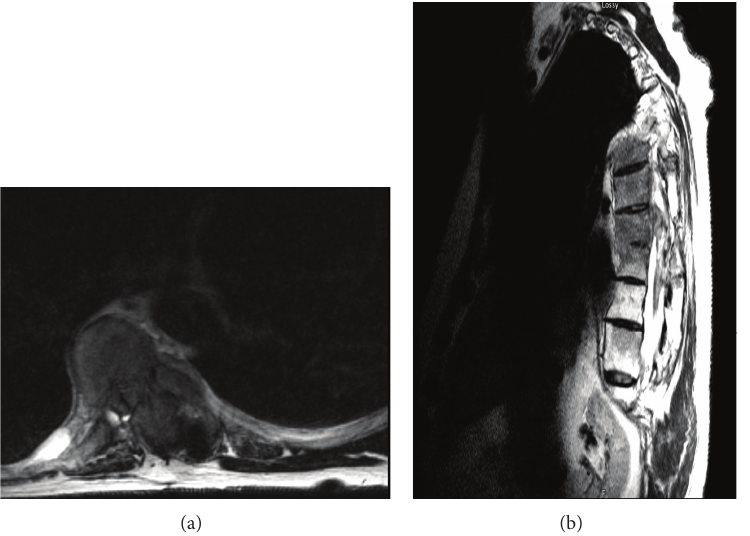
Figure 4: A year after his second resection. Axial and sagittal T2 MRI images of Thoracic spine show anterior lateral tumor recurrence with spinal cord compression to the left. Complete CSF block at T8-9 was